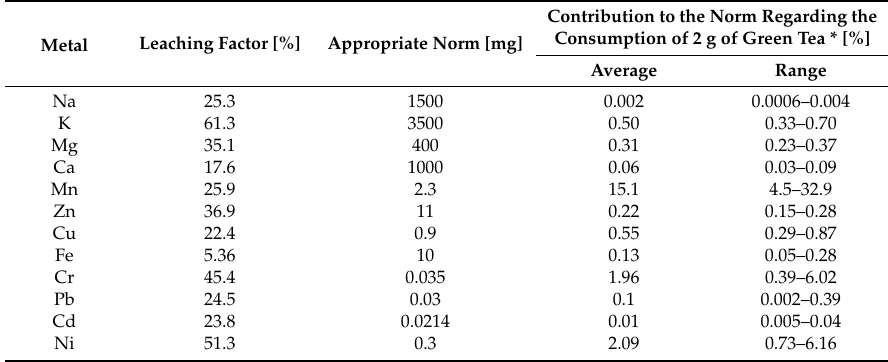
Contribution to the Norm Regarding the Consumption of 2 g of Green Tea * [%] Average Range